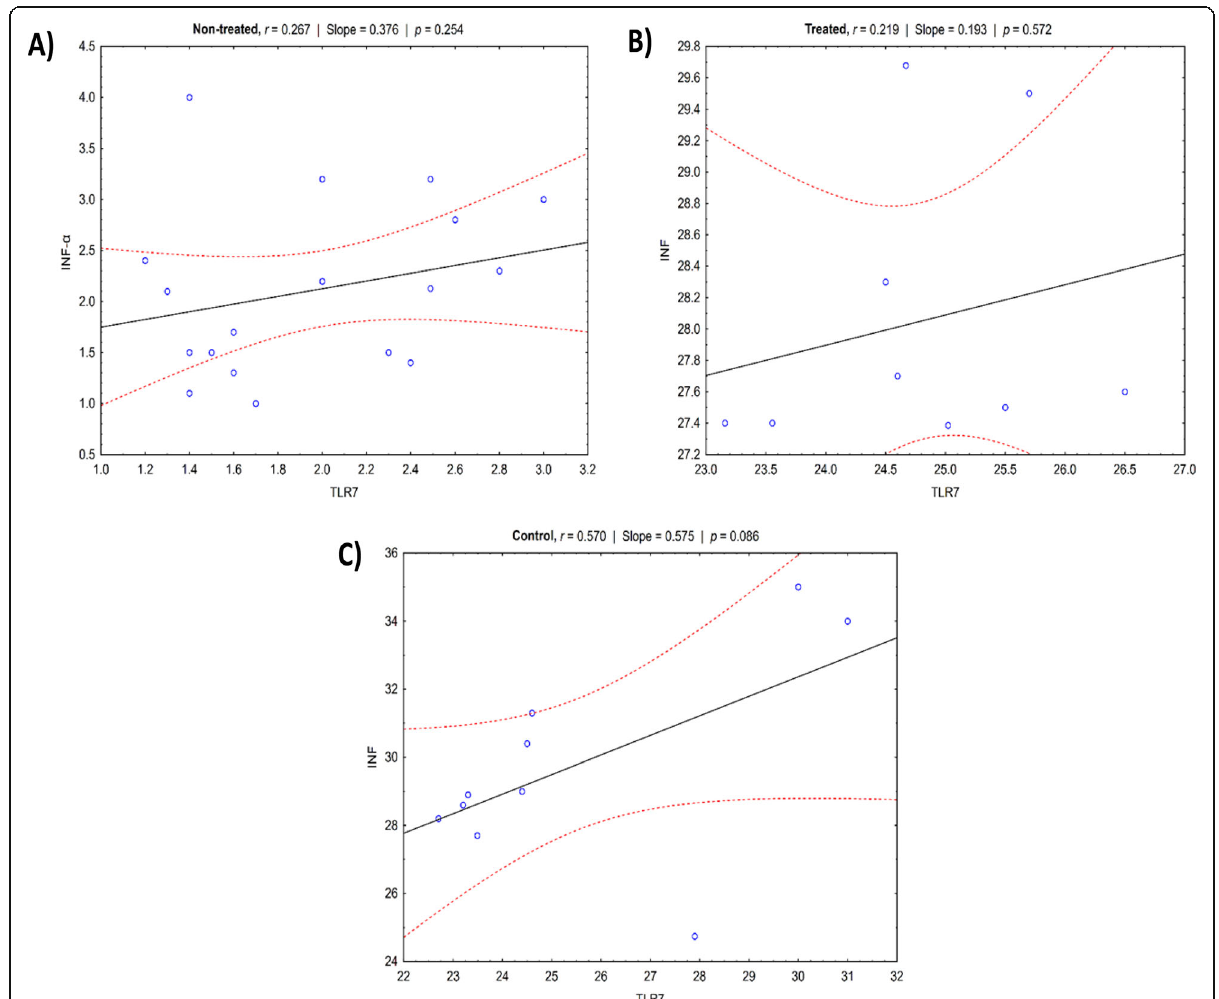
Fig. 5 a The correlation between expression levels of TLR7 and IFN- α in non-treated chronic HCV patients. b The correlation between expression levels of TLR7 and IFN- α in treated HCV group. c The correlation between expression levels of TLR7 and IFN- α in the control